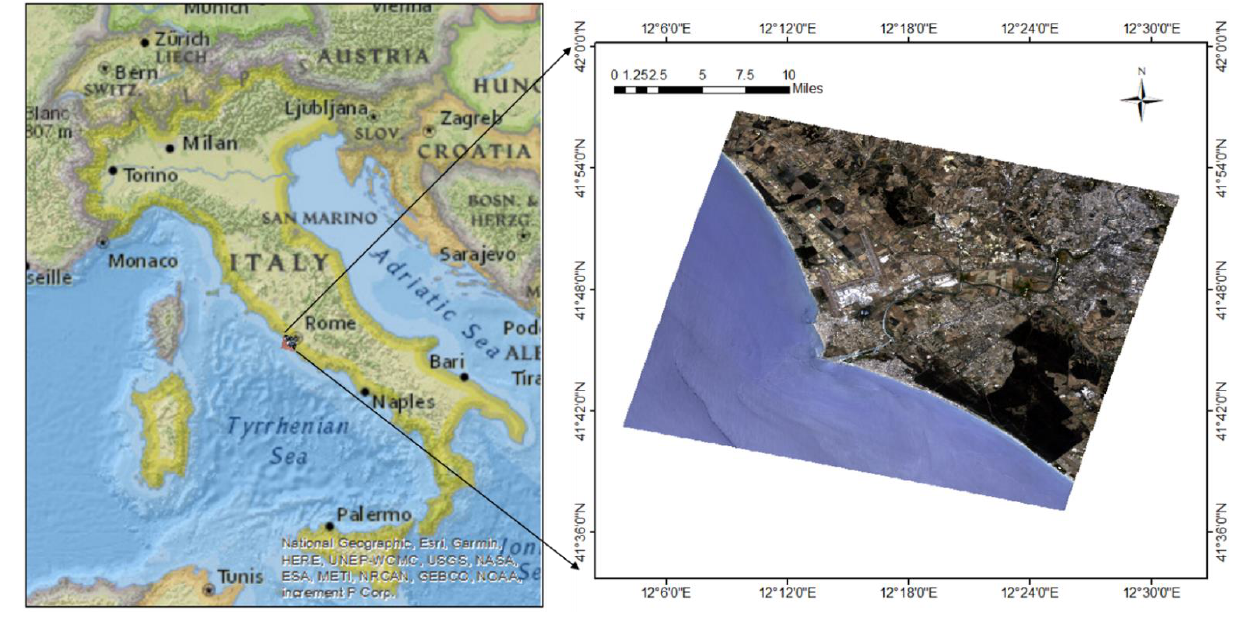
Figure 1. Region of interest (PRISMA image).